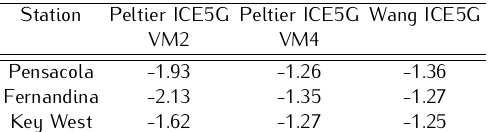
Table 2. Station uplift rates around Florida Panhandle due to the post glacial rebound (mm/yr) from various models (Peltier 2004, Wang,